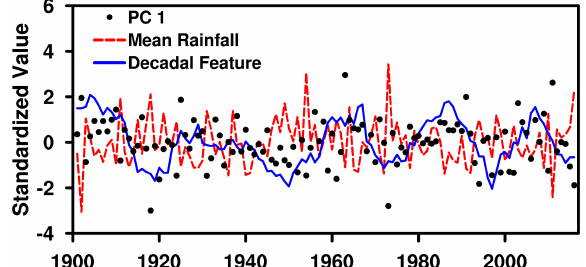
Figure 8. Standardized time series of all wet season precipitation over eastern China as shown by the red dashed line. The black dots denote flipped PC1 and the blue lines denote the decadal features of wet season